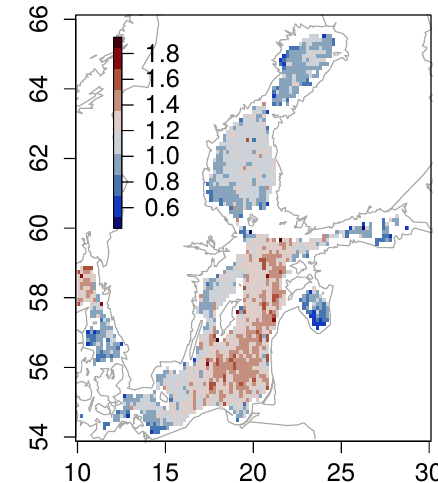
Figure 2. Average significant wave height (m; color scale) in the Baltic Sea in 1993–2015 from satellite altimetry. The approximate pixel size is 0.2 × 0.1 ◦ (100 × 100 pixel